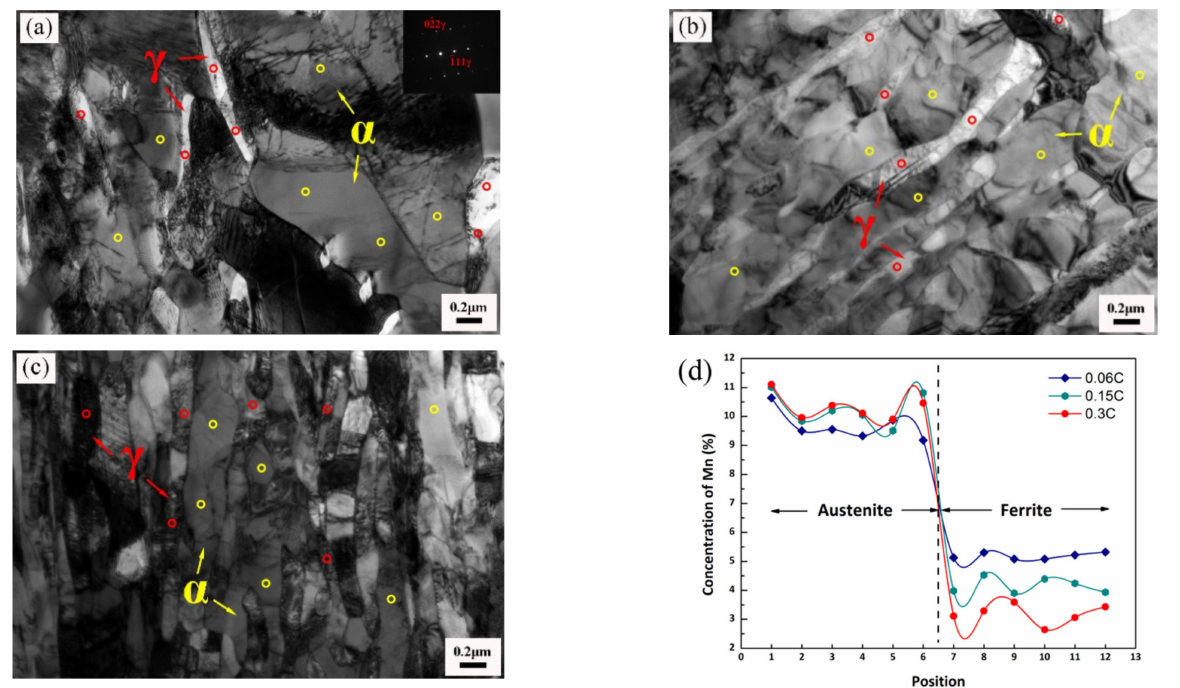
Figure 10. TEM micrograph and Mn concentration in austenite and ferrite. ( a ) 0.06C steel. ( b ) 0.15C steel. ( c ) 0.3C steel. ( d ) Mn concentration in austenite and